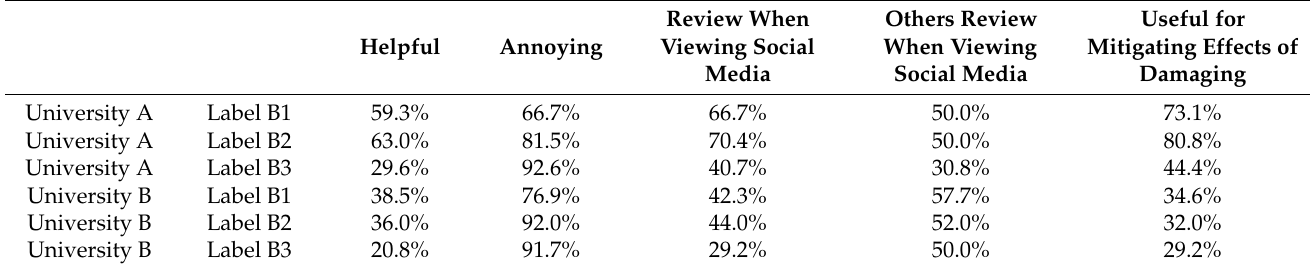
Table 10. Results of survey 3, by label and by university.